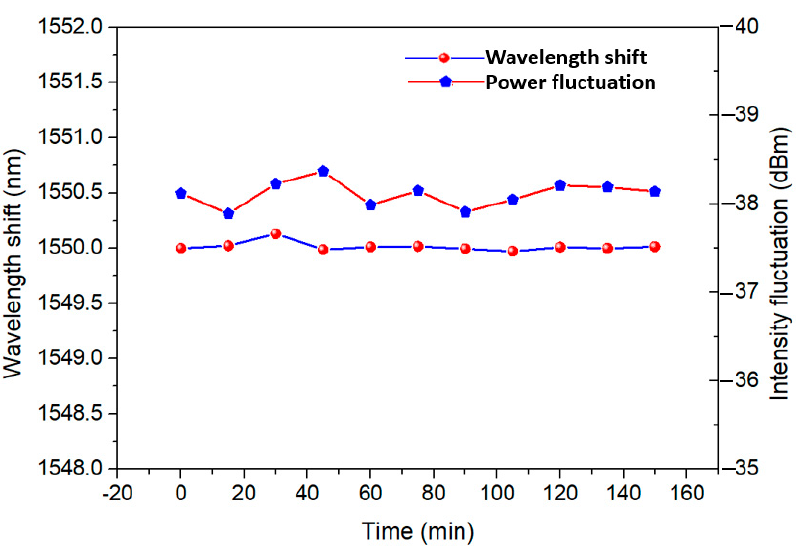
Figure 9. Test for time stability of wavelength shift and power fluctuation.